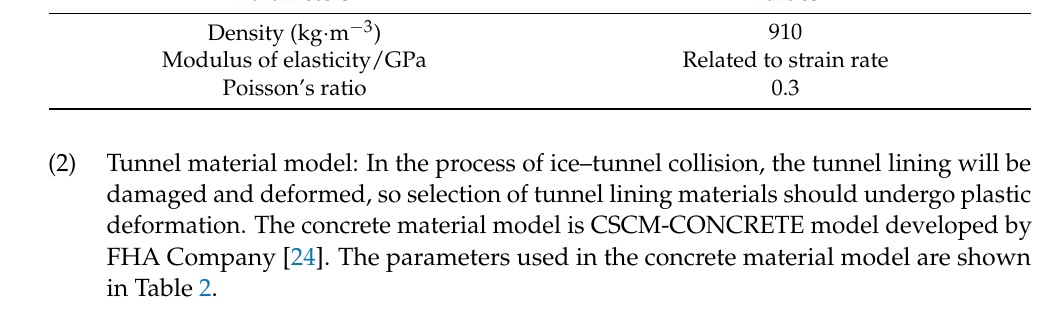
Table 2. Parameters of the concrete material